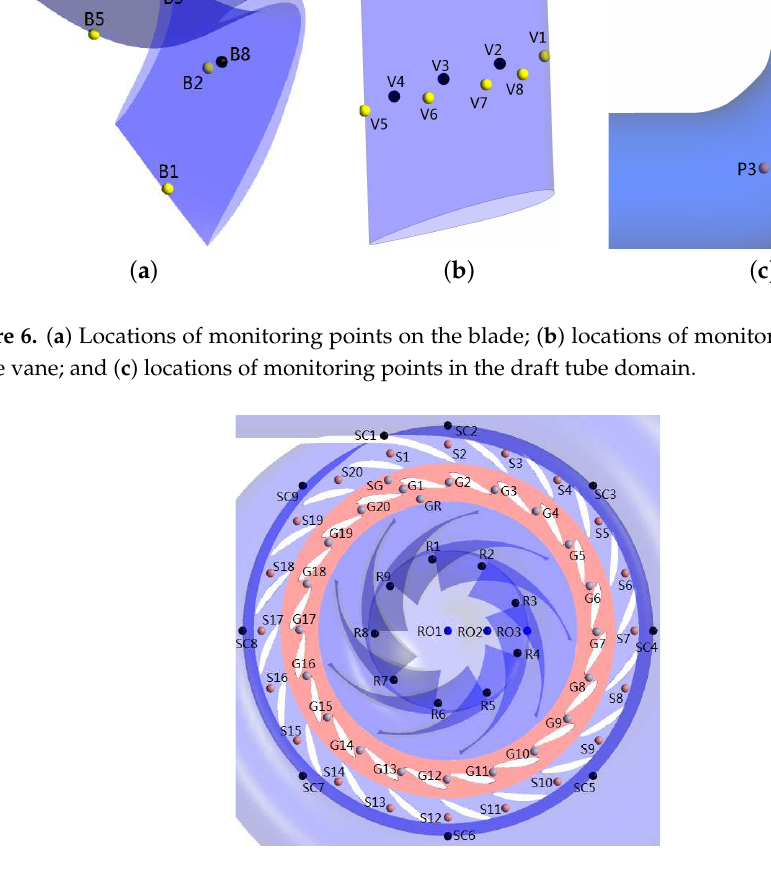
Figure 7. Top view representation of the distribution of the monitoring